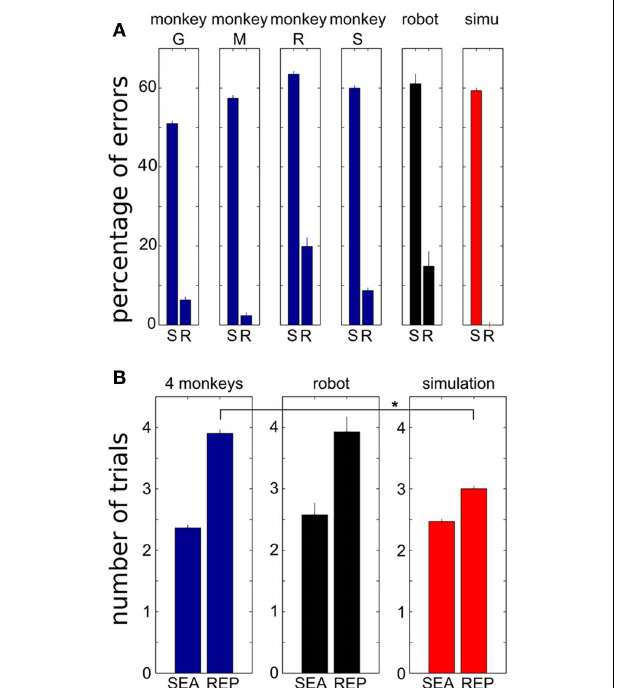
FIGURE 7 | Comparison of simulation results, robotics results and behavioral data obtained in monkeys performing Experiment 1. The percentage of errors (A) and the duration of problems (B) performed by the robot were not different from that of monkeys. In contrast, simulation of the model provided perfect performance. S/SEA, search; R/REP, repetition. Errorbars: SEM. “*” Indicates significant difference via Kruskal–Wallis test, p <